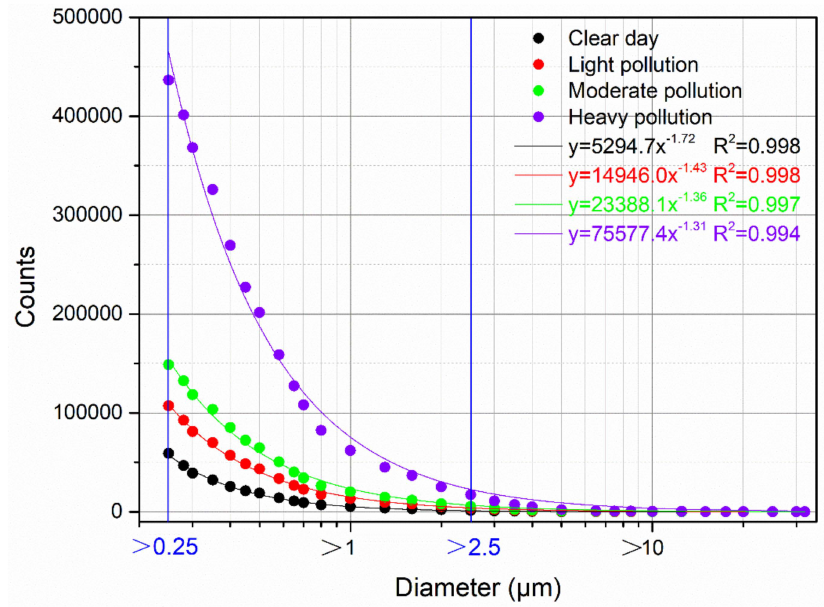
Figure 3. Distribution of surface particle size under different dust pollution levels near-surface in TZ during July